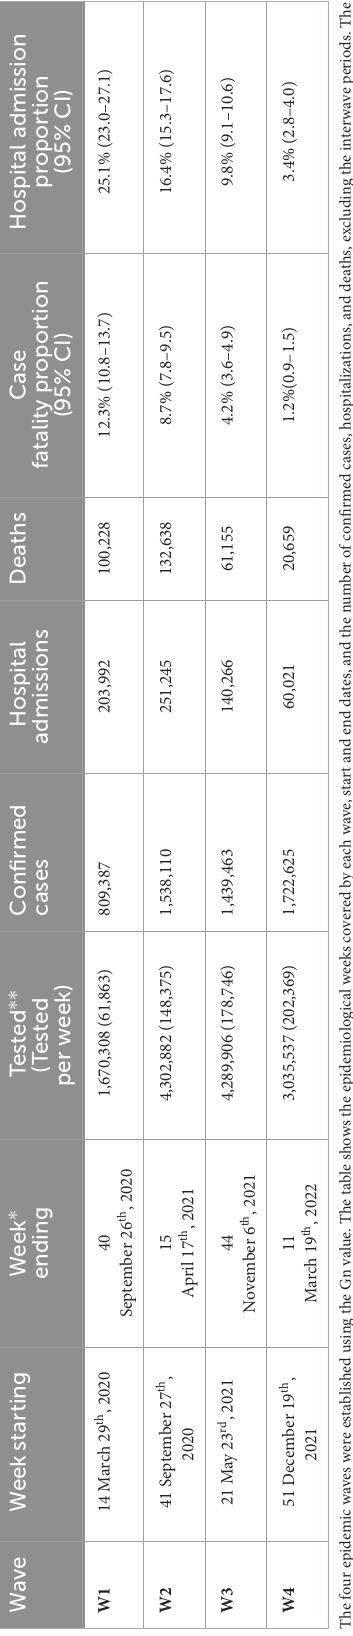
TABLE 3 Hospital admissions